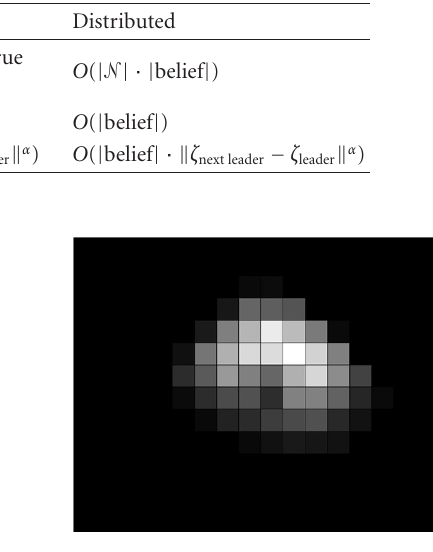
Figure 1: Nonparametric representation of belief